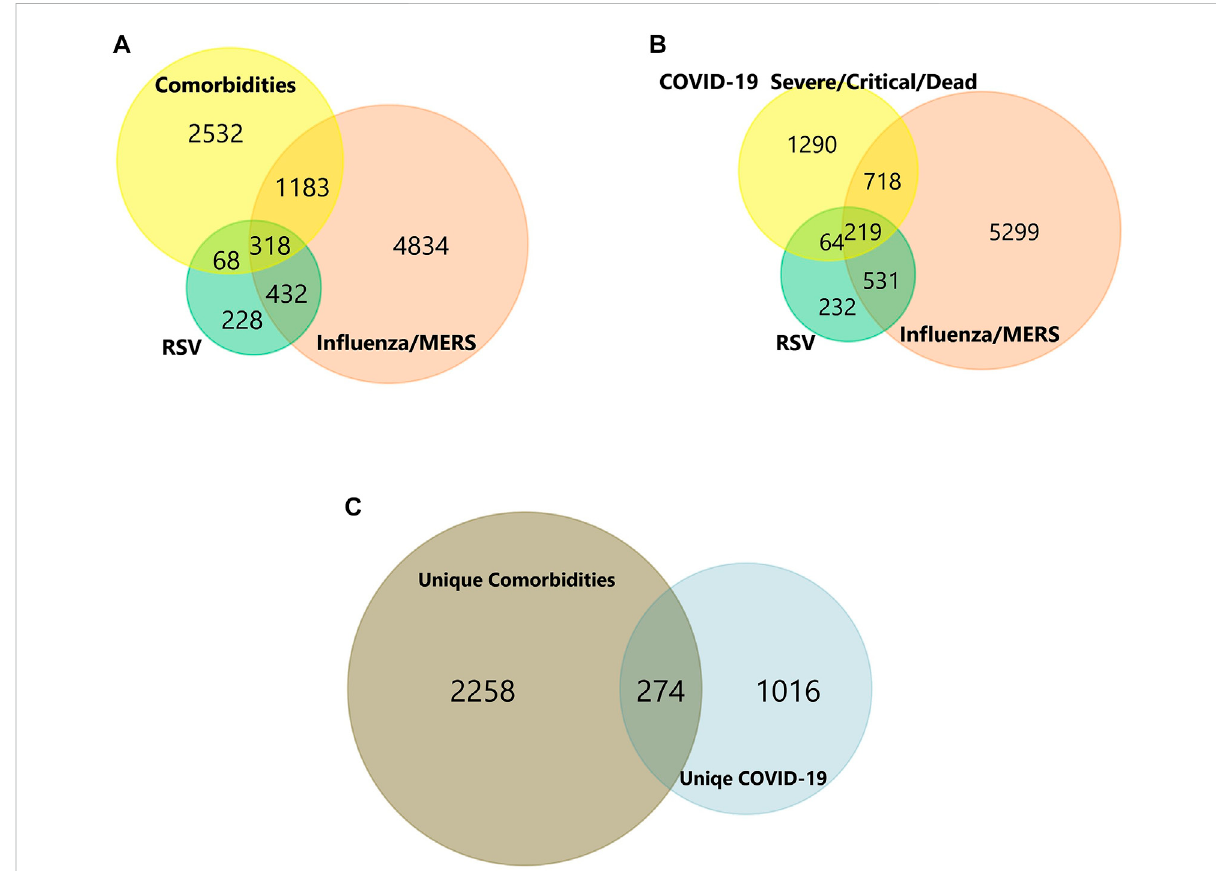
FIGURE 3 (A-C) VenndiagramofsharedanduniquegenesofComorbiditiesandCOVID-19infection.Colorsrepresentdifferentdatasets.Theoverlapping areas are the shared DEGs. Statistically signi fi cant DEGs were de fi ned with p < 0.05 and [log2FC] > 1.5 as the cut-off